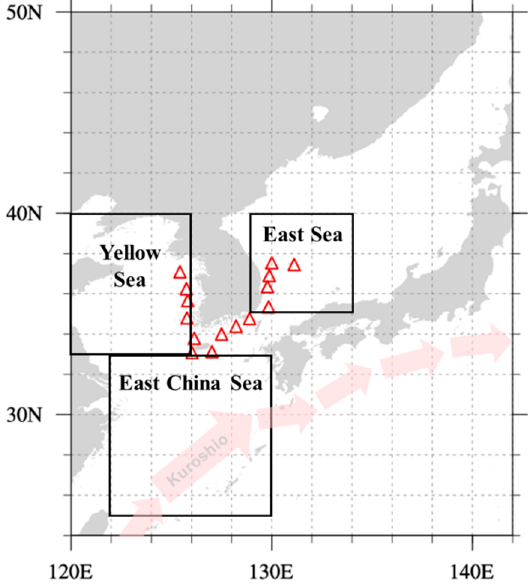
Figure 1. Spatial distribution of marine buoys (red triangles) around the Korean Peninsula and the ocean sectors involved. Arrows indicate the Kuroshio current.